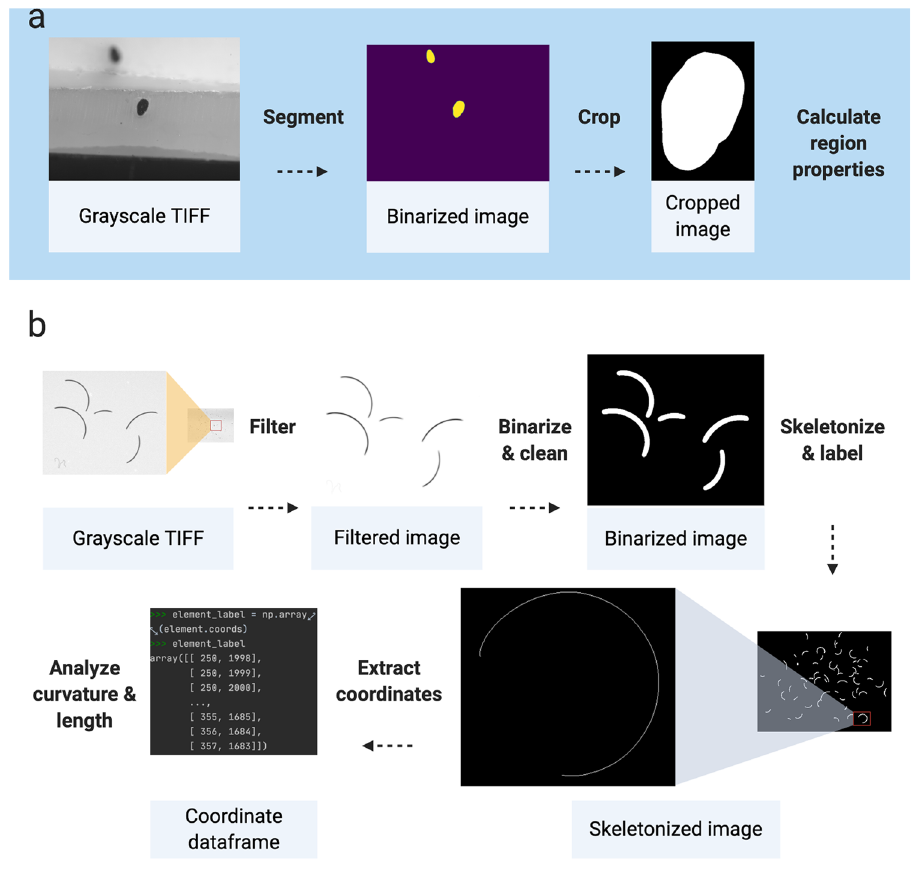
Figure 3. Fibermorph image analysis workflow. (a) Cross-sectional image processing and analysis. ( b ) Curvature image processing and